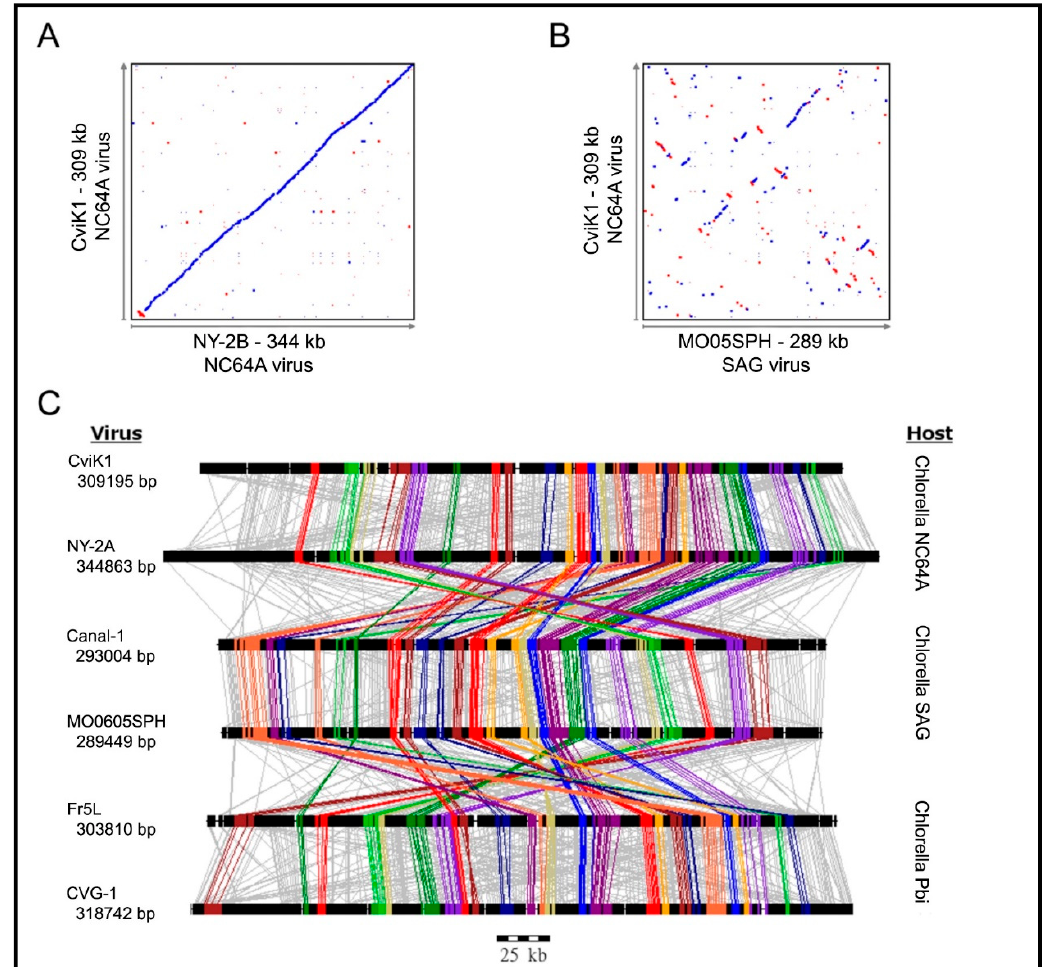
Figure 6. Gene dot-blots and gene alignments across chlorovirus host types. Dot-blot alignments of two chlorovirus genomes infecting the same ( A ) or different ( B ) hosts (blue indicates common genomic orientation, red indicates opposite genomic orientation). Each dot represents a protein match (ortholog) between the two viruses (BLASTp expect value > 1 × 10 − 5 ). ( C ) Schematic representation of six chlorovirus genomes from three different hosts. Each genome is depicted as a black line with genic regions represented by black boxes. Lines connect genes from the same family of homologous proteins (for clarity purpose, the six bigger families were removed from the figure). The colored set of genes and lines represents the Gene Gangs referred to in the text. While viruses that infect the same host demonstrate good conservation of synteny ( A ), synteny is poorly conserved across the virus types ( B ). Despite generally poor syntenic conservation, gene-centric alignments suggest that some conserved collinear blocks exist ( C ). Figure taken from Seitzer et al. [74] and published with permission.